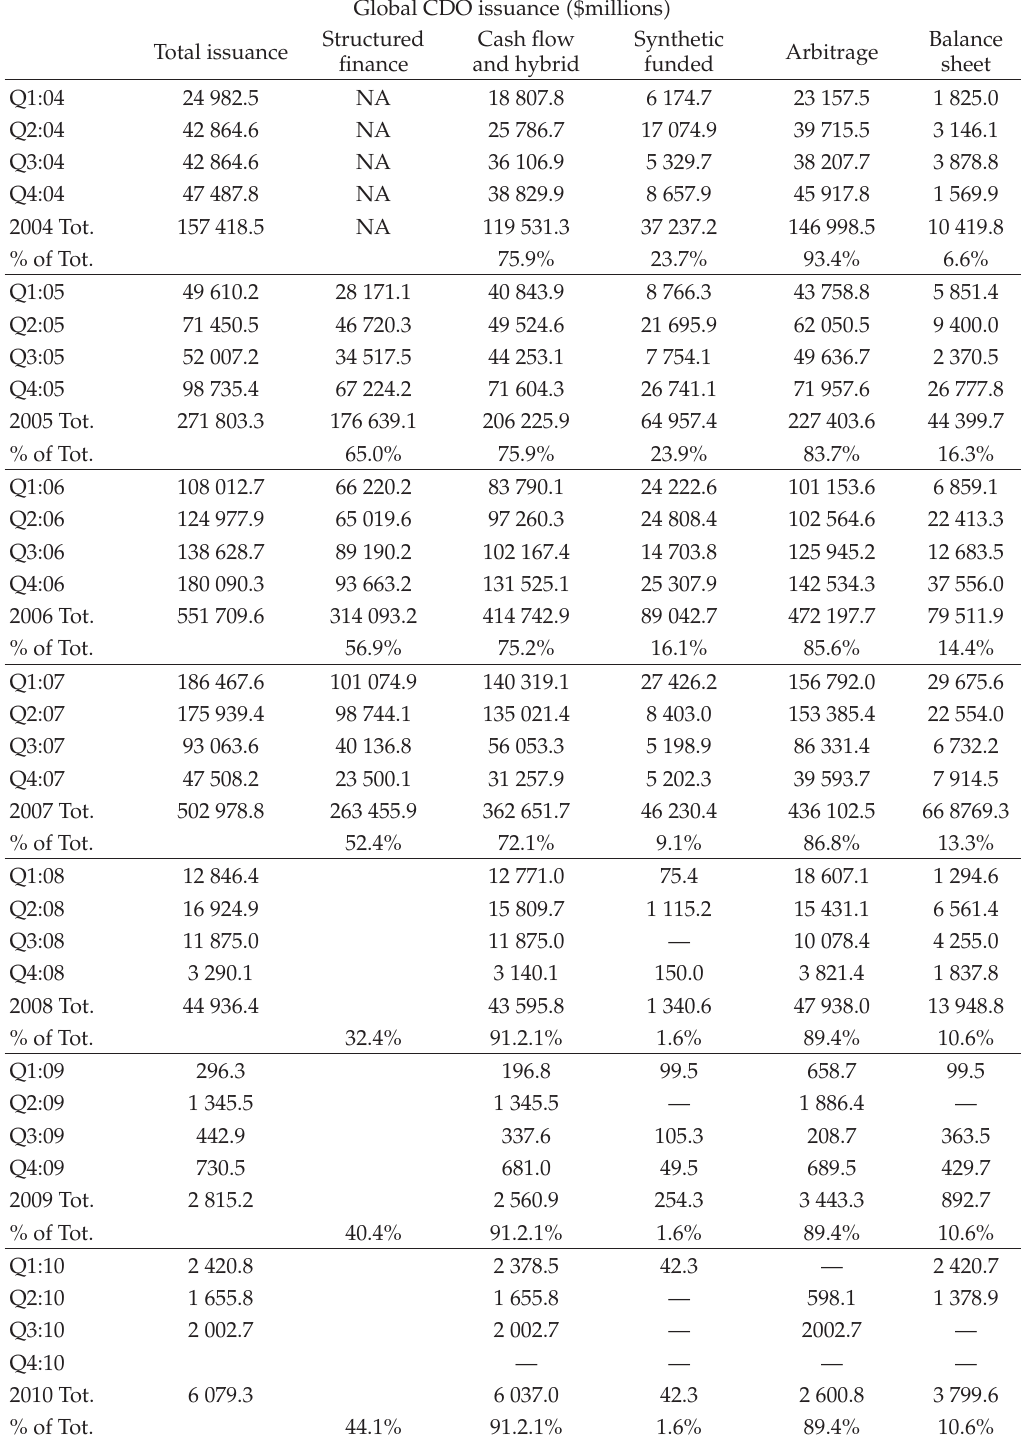
Table 1: Global CDO issuance (cid:2) $millions (cid:3) ; source: (cid:6) 22 (cid:7)